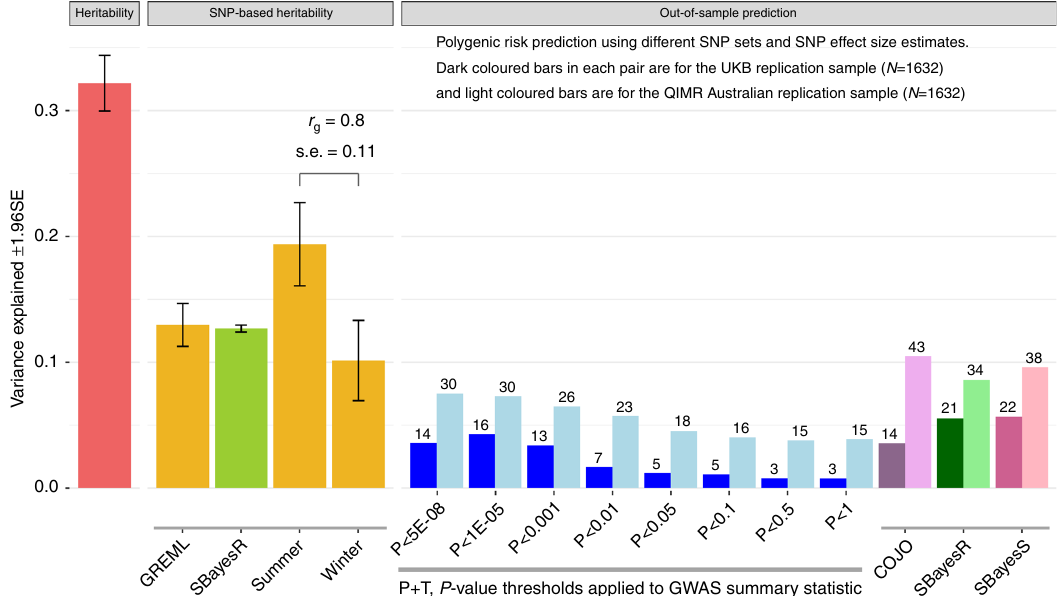
Fig. 2 Heritability, SNP-based heritability and variance explained in out-of-sample prediction. Heritability (left panel) and SNP-based heritability (middle panel) estimates and the variance explained in out-of-sample prediction (right panel). Heritability and SNP-based heritability estimates are presented with 95% con fi dence interval. GCTA-GREML was used to estimate heritability from a UKB subset that included all pairs of individuals related with coef fi cient of relationship > 0.2 ( N = 58,738 relatives). GCTA-GREML was used to estimate SNP-based heritabilities labelled GREML summer or winter using samples of ~50 K participants randomly drawn from the UKB. The SBayesR SNP-based heritability is estimated from the GWAS summary statistics ( N = 417,580). In out-of-sample prediction into the QIMR and the UKB replication (UKBR) samples, polygenic risk scores (PRS) calculated by the standard P -value threshold method (P + T) were outperformed by using SNP effect estimates calculated from GWAS summary statistics using the SBayesR or SBayesS methods. Bars of the same colour used the same methodology (noting that SBayesR generates an estimate of SNP-based heritability as well as SNP effect sizes in prediction analysis). The numbers on top of the bars are − log10 P -value of the regression of 25OHD on 25OHD PRS. COJO conditional and joint, rg genetic correlation, s.e. standard